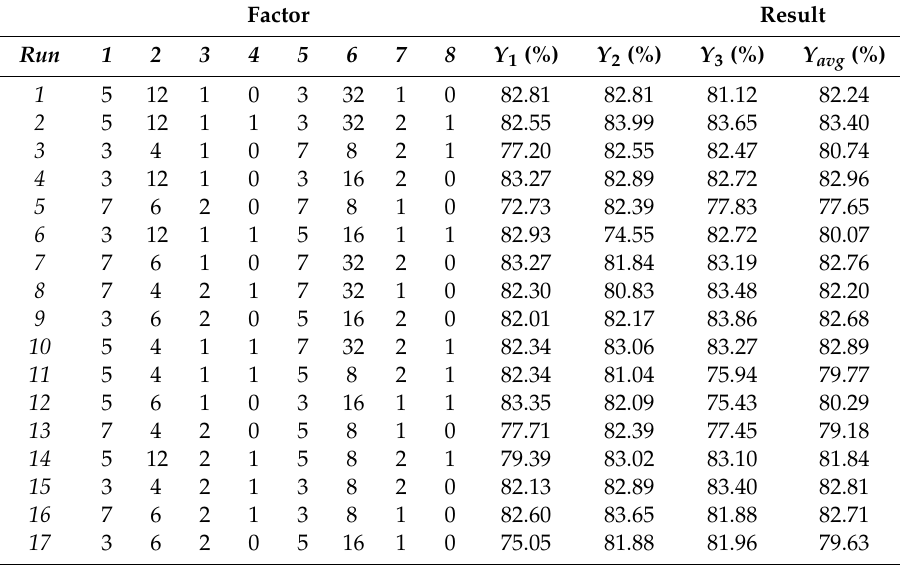
Table 8. Comparison results between run 2 and the UED with the best parameters in the experiment. Run Parameter of Factors Performance (%)